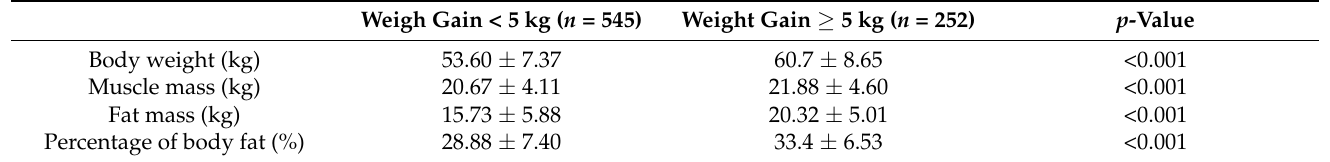
Table 3. Comparison of body composition according to degree of weight gain. Weigh Gain < 5 kg ( n =